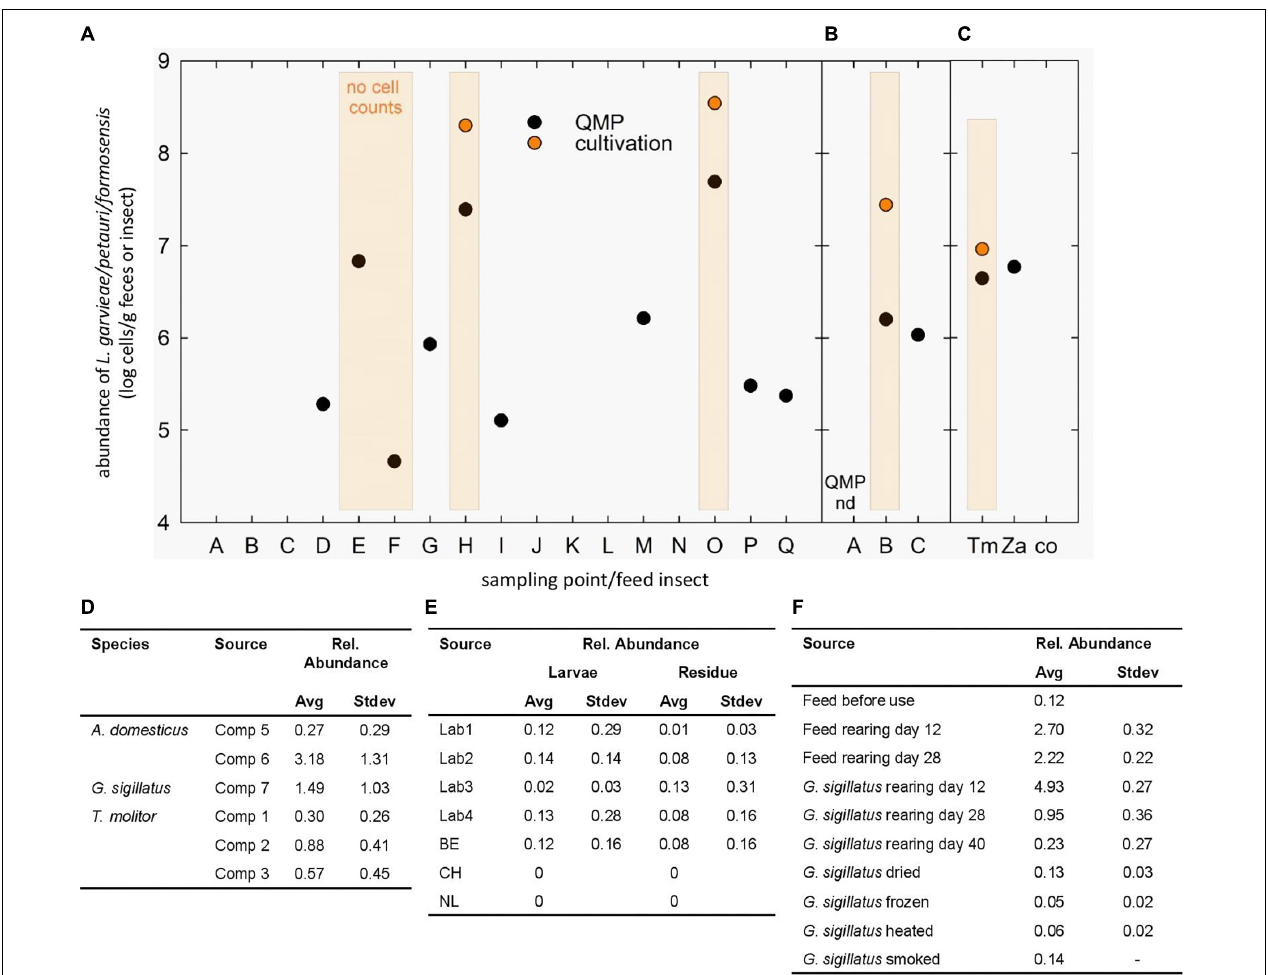
FIGURE 1 | Occurrence of L. garvieae/petauri/formosensis in monkeys and feed insects. (A-C) Cell counts of L. garvieae/petauri/formosensis in male (A) and female (B) monkeys and feed insects (C) determined by QMP and cultivation at different sampling points. The minimal detection limit of QMP was around log 4 cells g − 1 . Orange-shaded columns indicate the presence of orange-pigmented colonies on WSP agar. No cell count, orange-pigmented colonies were detected, but cell counts were not recorded. (D-F) Reanalysis of available 16S rRNA gene datasets to determine the occurrence of L. garvieae/petauri/formosensis in two crickets and one mealworm species reared at different companies ( D ; Vandeweyer et al., 2017), of mealworms and their residues reared in different labs and countries ( E ; Vandeweyer et al., 2018), and of the cricket G. sigillatus during rearing and after processing ( F ; Wynants et al.,